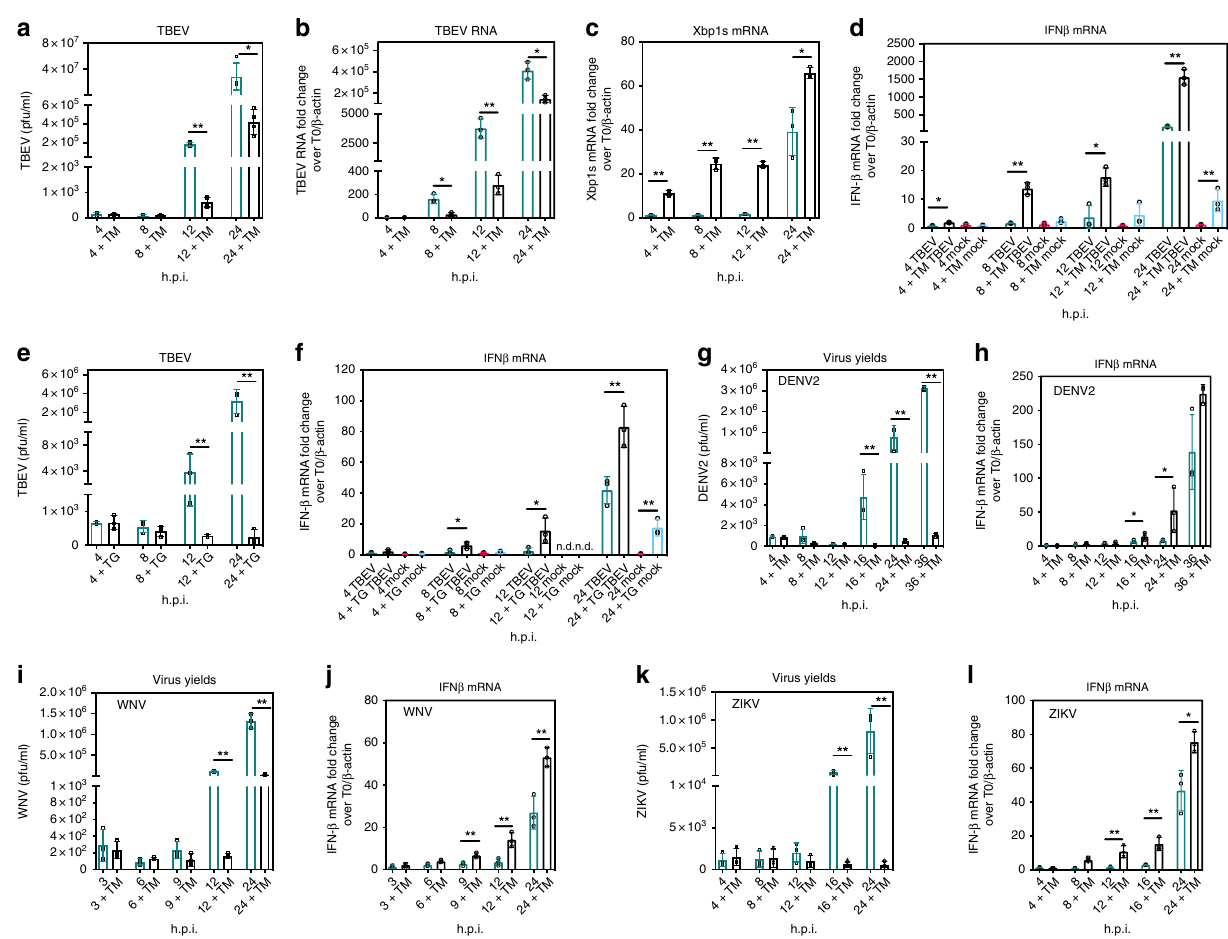
Fig. 2 Modulation of the interferon response to fl avivirus infection by the UPR. a Tunicamycin treatment inhibited TBEV yields. U2OS cells were either infected with TBEV at moi = 1 (blue bars) or treated with 1 μ g/ml Tunicamycin (TM) immediately after infection (black bars). At the indicated time points, supernatants from infected cells were used to infect Vero cells to measure virus yields (PFU/ml). b – d Tunicamycin treatment inhibited TBEV RNA, increased Xbp1s and led to early IFN β induction. U2OS cells were infected as in a . Total RNA was extracted at the indicated time points and used as template for qPCR using primers speci fi c for TBEV 5 ′ -NCR ( b ), Xbp1s ( c ) or IFN β ( d ). β -actin was used for normalization and data plotted as fold change from time 0. Values of IFN β mRNA from mock-infected cells treated with Tunicamycin alone were also indicated ( d , azure bars). e , f Thapsigargin treatment inhibited TBEV yields and led to early IFN β induction. U2OS cells were infected with TBEV at moi = 1 (blue bars) or treated with 0.5 μ M Thapsigargin (TG) immediately after infection (black bars) and treated as above ( b , d ). g – l Tunicamycin treatment inhibited DENV2, WNV, and ZIKV yields and led to early IFN β induction. U2OS cells were either infected (blue bars) or treated with Tunicamycin (TM) immediately after infection (black bars). At the indicated time points, supernatants from infected cells were either used to infect Vero cells to measure virus yields (DENV2 g, WNV i , ZIKV k ) or total RNA was extracted and used as template for real-time qPCR to quantify IFN β mRNA (DENV2, h ; WNV, j ; ZIKV, l ). Statistics as already described in the legend of Fig. 1. Source data are provided as a Source Data fi